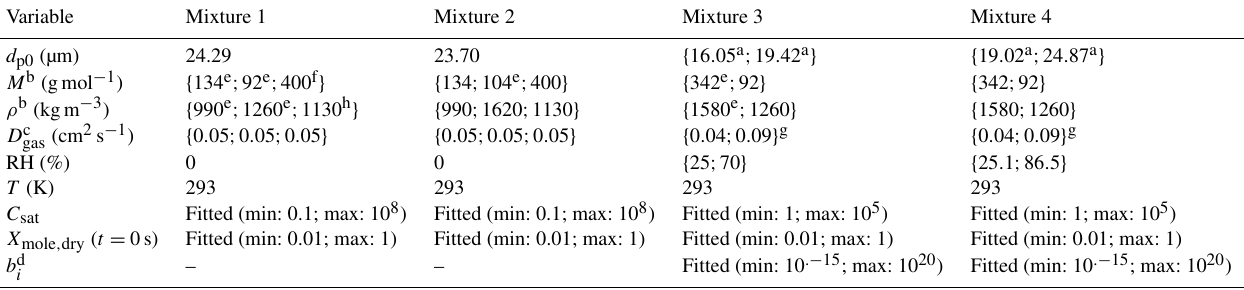
Table 5. The properties of the organic compounds for the particles generated from mixtures 1–4. The variables are, from top to bottom, parti- cle diameter at the start of the evaporation, molar mass, particle-phase density, gas-phase diffusion coefficient, relative humidity, temperature, saturation concentrations of the VBS compounds, mole fraction of the compounds at the start of the evaporation and viscosity parameters b in Eq. (1).